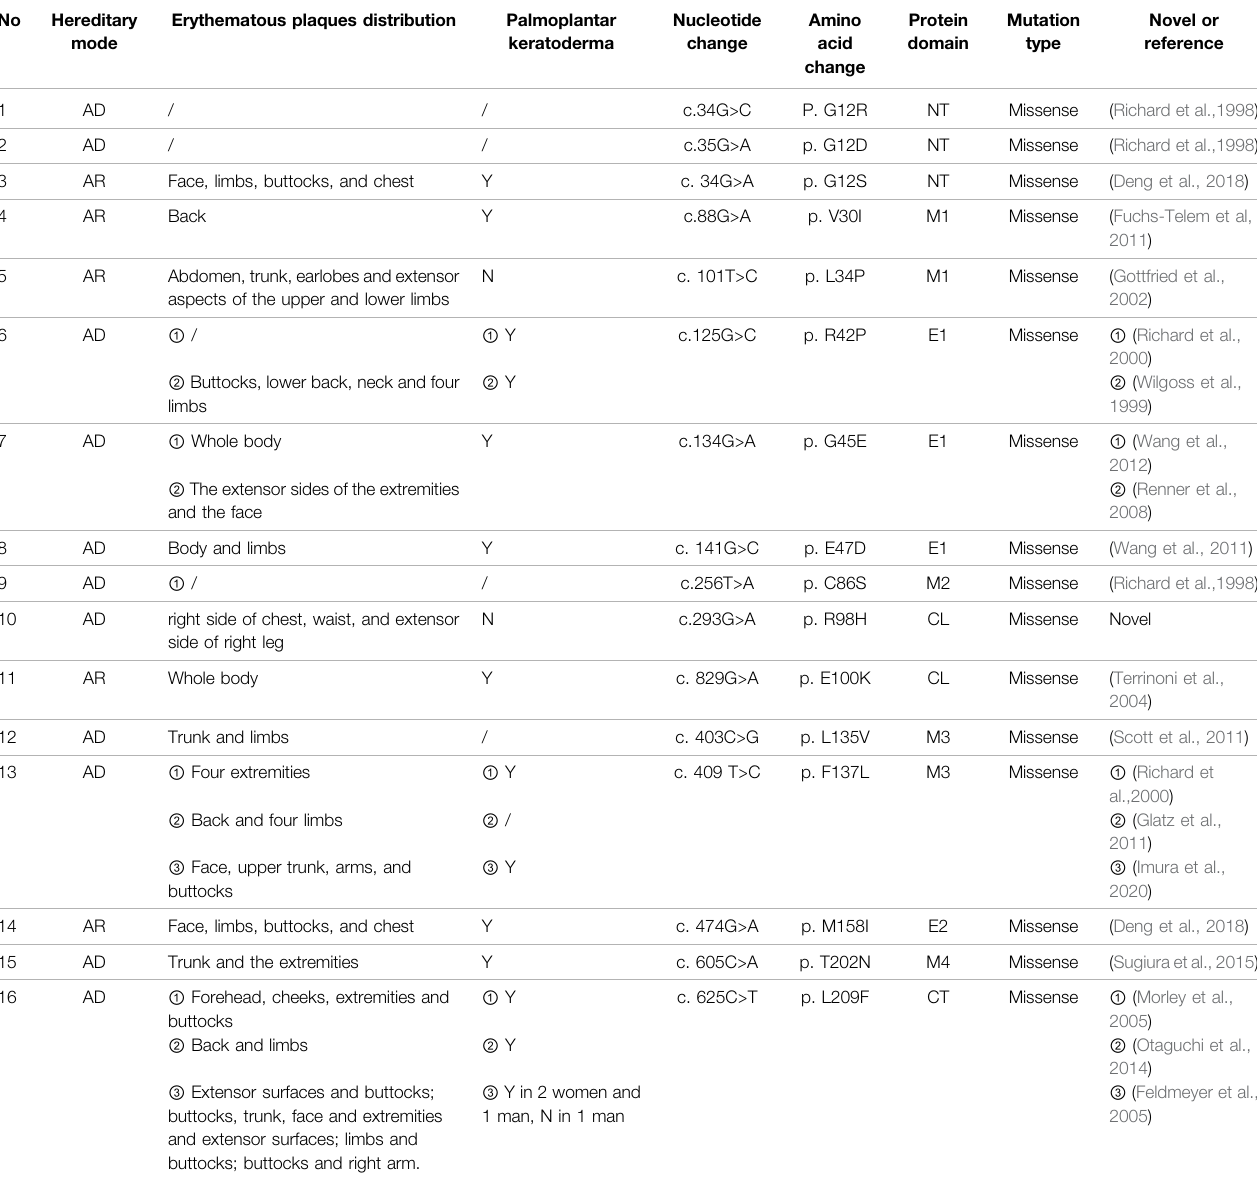
TABLE 1 | Reported pathogenic mutations in GJB3 related to EKV and